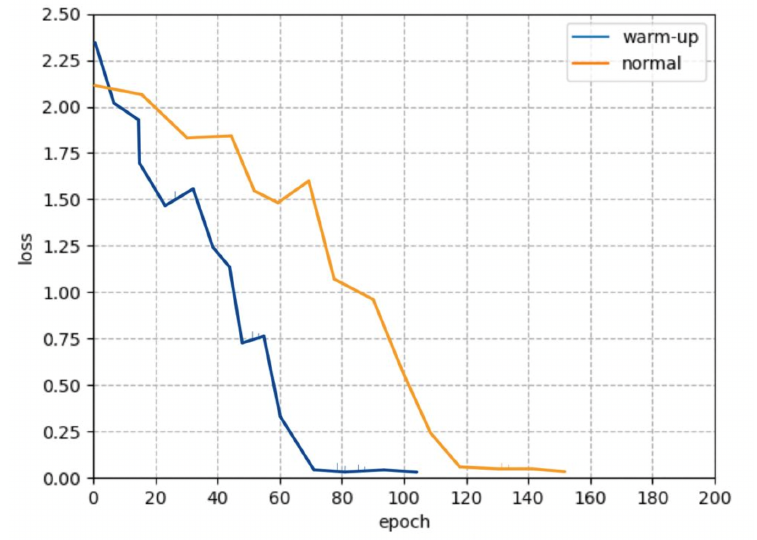
Figure 17. Loss curve of different models and methods.